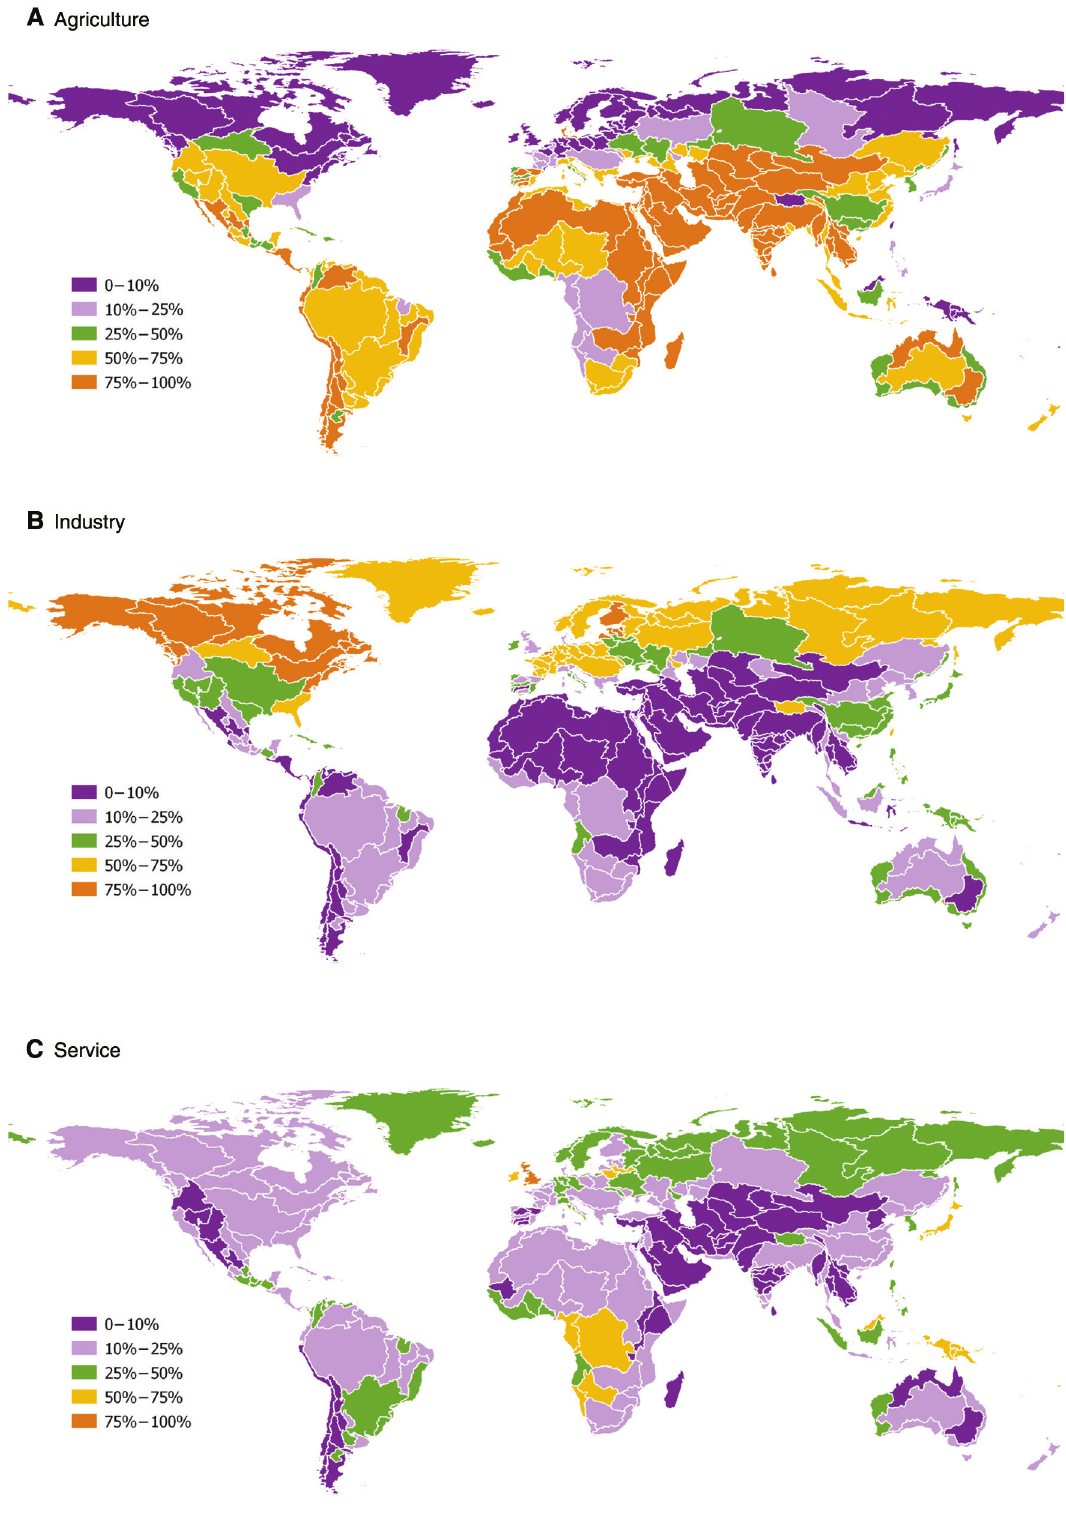
Proportion of the agriculture (A), industry (B), and service (C) sector freshwater withdrawal with respect to the total freshwater withdrawal per major river basin (reference year 2018). Geographic